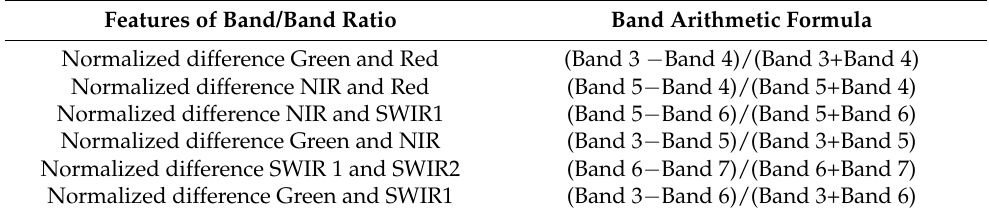
Table 2. Cont. Features of Band/Band Ratio Band Arithmetic Formula Normalized difference Green and Red (Band 3 − Band 4)/(Band 3+Band 4) Normalized difference NIR and Red (Band 5 − Band 4)/(Band 5+Band 4) Normalized difference NIR and SWIR1 (Band 5 − Band 6)/(Band 5+Band 6) Normalized difference Green and NIR (Band 3 − Band 5)/(Band 3+Band 5) Normalized difference SWIR 1 and SWIR2 (Band 6 − Band 7)/(Band 6+Band 7) Normalized difference Green and SWIR1 (Band 3 − Band 6)/(Band 3+Band